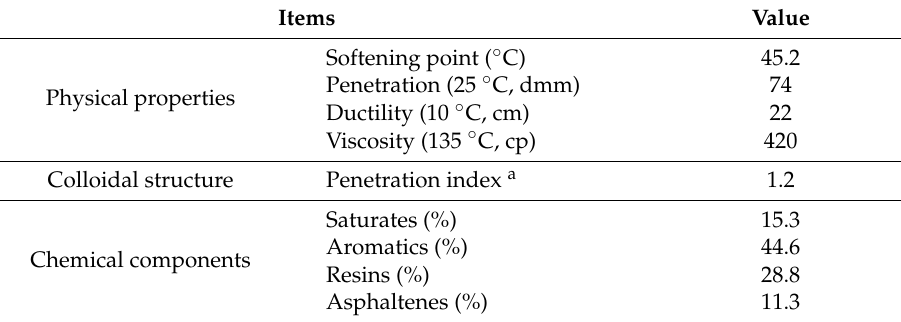
Table 1. Physical properties and chemical components of virgin bitumen. Items